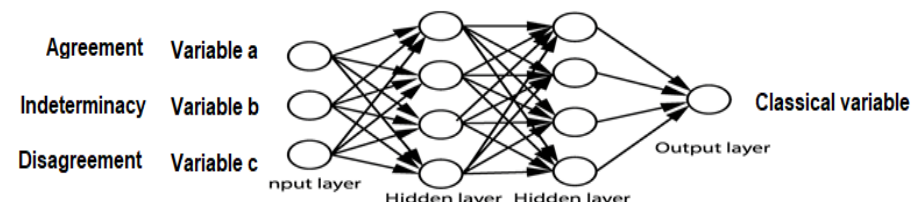
Fig. 10. The general structure of the Convolutional Neural Network (CNN) we used in this study is a three-layer neural network with three input neurons, two hidden layers of four neurons each, and one output layer